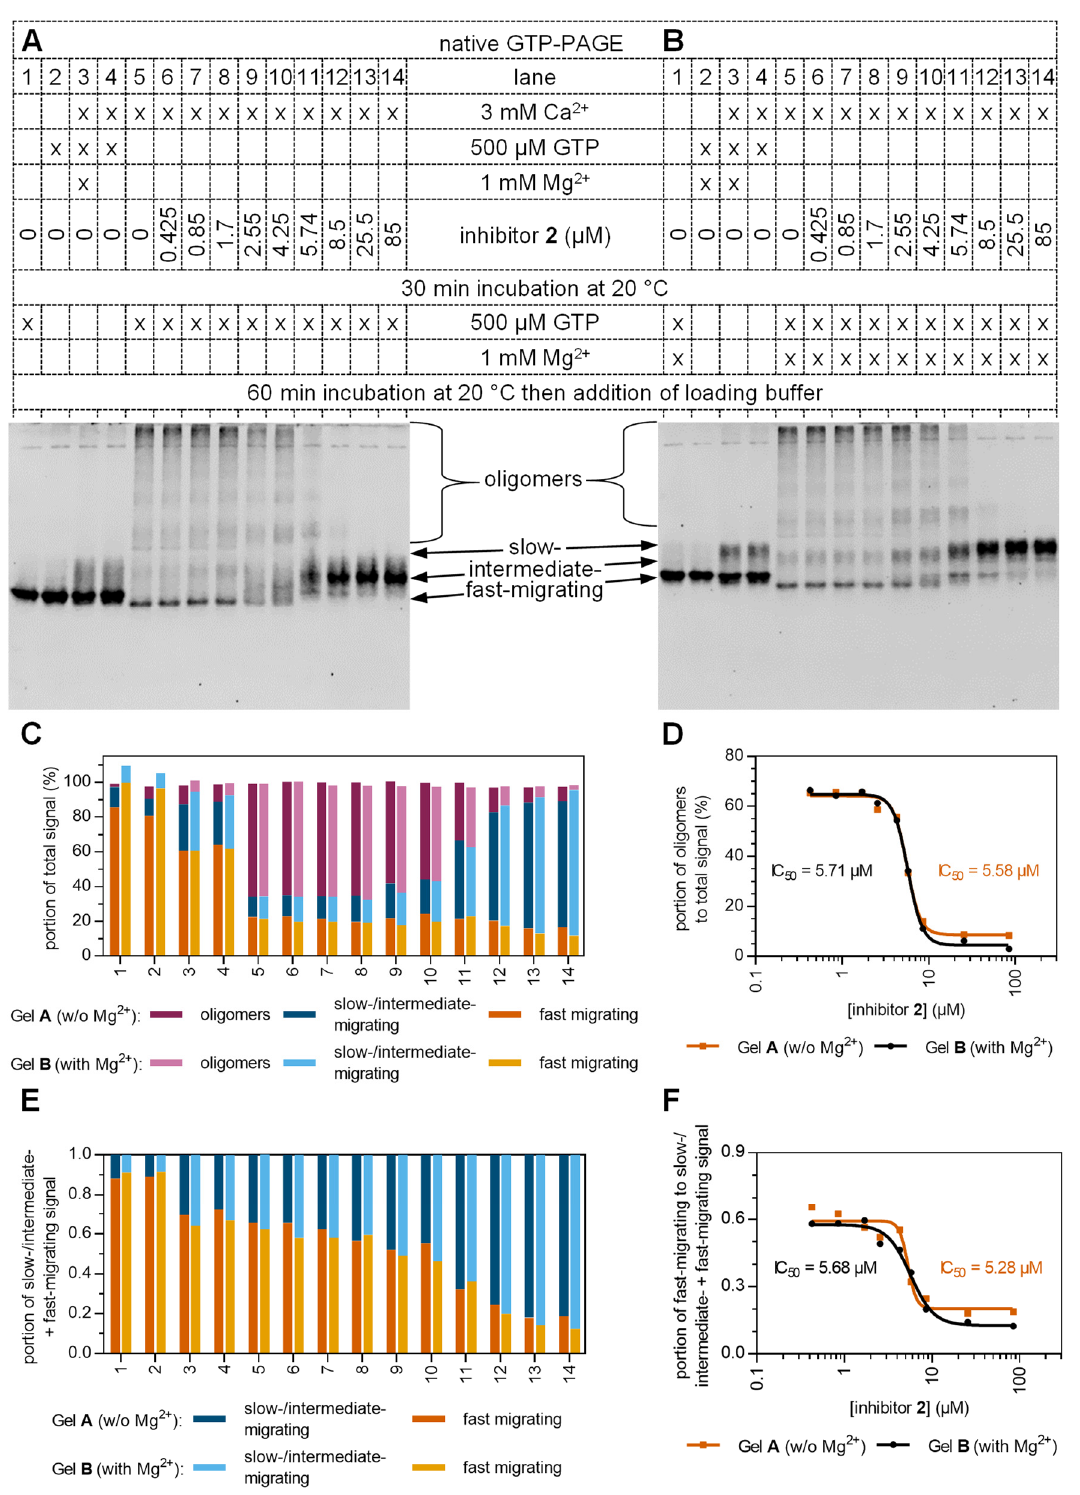
Figure 8. Effect of increasing concentrations of inhibitor 2 on the activity and the conformation of hTGase 2. Native GTP-PAGE was performed on 7% separating gels. Both the gel and the running buffer contained 50 µM GTP without ( A ) and with an additional 500 µM MgCl 2 ( B ). Samples of 8.23 µM self-produced hTGase 2 were first incubated for 30 min at 20 °C in 100 mM MOPS pH 8.0, 100 mM NaCl, 2.12% ( v / v ) DMSO, 5.33% ( v / v ) glycerol with CaCl 2 , GTP, MgCl 2 , and different concen- trations of inhibitor 2 , as indicated. GTP and/or MgCl 2 were added as indicated, and all samples were incubated for 60 min at 20 °C. After adding native loading buffer, 6 µL of each sample con- taining 3 µg of hTGase 2 was loaded onto the gel. After electrophoretic separation, gels were stained